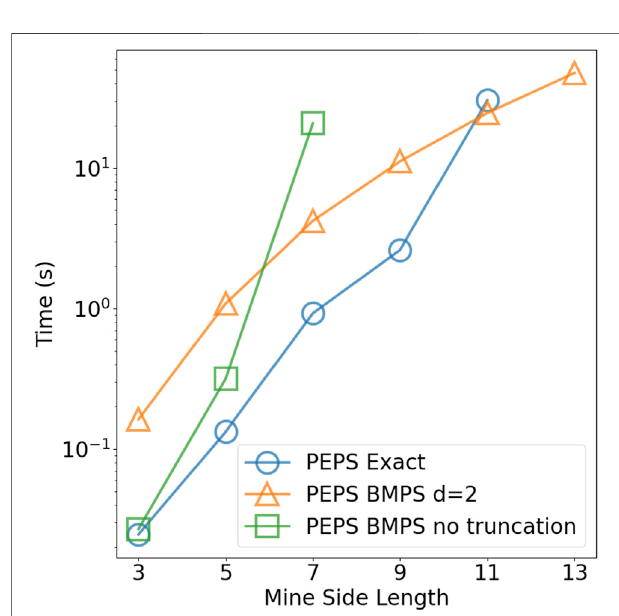
FIGURE 5 | Computational time for two-dimensional open-pit mining problems with mine side length ranging from 3 to 13, using three different PEPS contraction